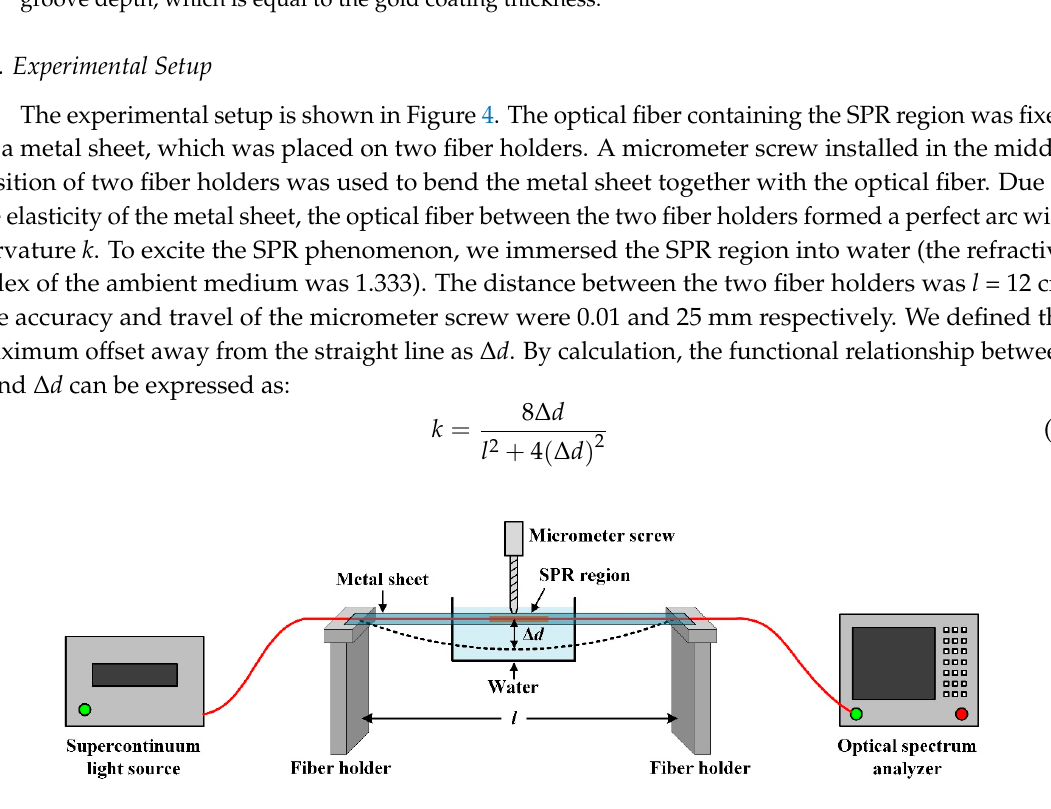
Figure 3. ( a ) Three-dimensional testing result for the gold coating with a groove; ( b ) test result for the groove depth, which is equal to the gold coating thickness.